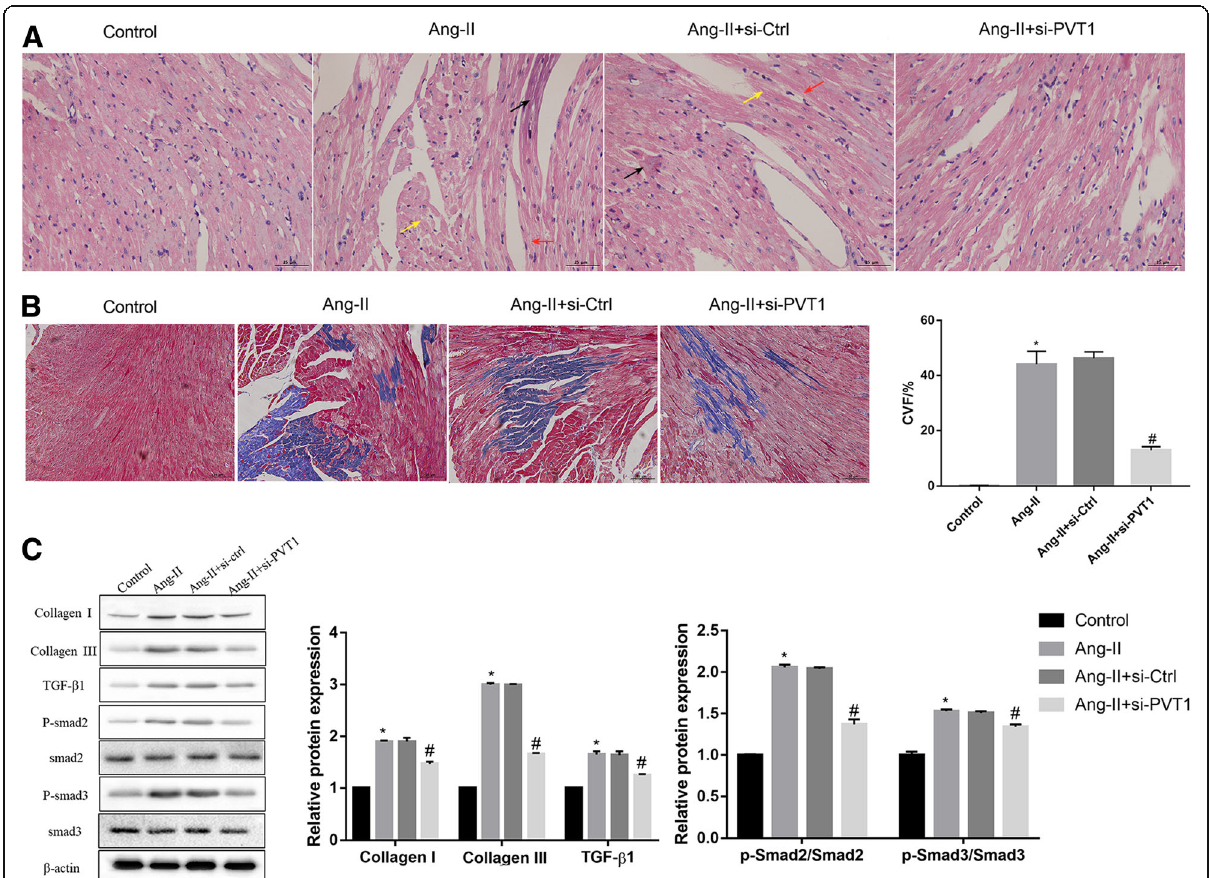
Fig. 5 PVT1 knockdown attenuates the Ang-II-induced atrial fibrosis. Ang-II was injected into mice to induce cardiac fibrosis for 4 weeks, and si- PVT1 or si-Ctrl (as control) was subsequently injected into Ang-II-treated mice. Following 2 weeks of siRNAs injection, ( a ) HE staining was performed to evaluate the morphological changes of mouse atrial muscle tissues. Scale bar: 25 μ m. Black arrows indicate increased myocardial interstitial fibrosis; red arrows indicate expanded nuclear spacing; yellow arrows indicate myocardial fiber disarray. b Masson staining was performed to evaluate the degree of atrial fibrosis. Fibrotic tissue was stained in blue. Collagen volume fraction (CVF, %) was calculated. Scale bar: 25 μ m. c Western blot was performed to determine the protein expression of Collagen I, Collagen III, TGF- β 1, Smad2 and Smad3 in mouse atrial muscle tissues. β -actin served as the loading control. c * P < 0.05 vs. control, # P < 0.05 vs. Ang-II + si-Ctrl. N = 8 mice in each group. Data are presented as mean ± SD. PVT1, plasmacytoma variant translocation 1; TGF- β 1, transforming growth factor- β